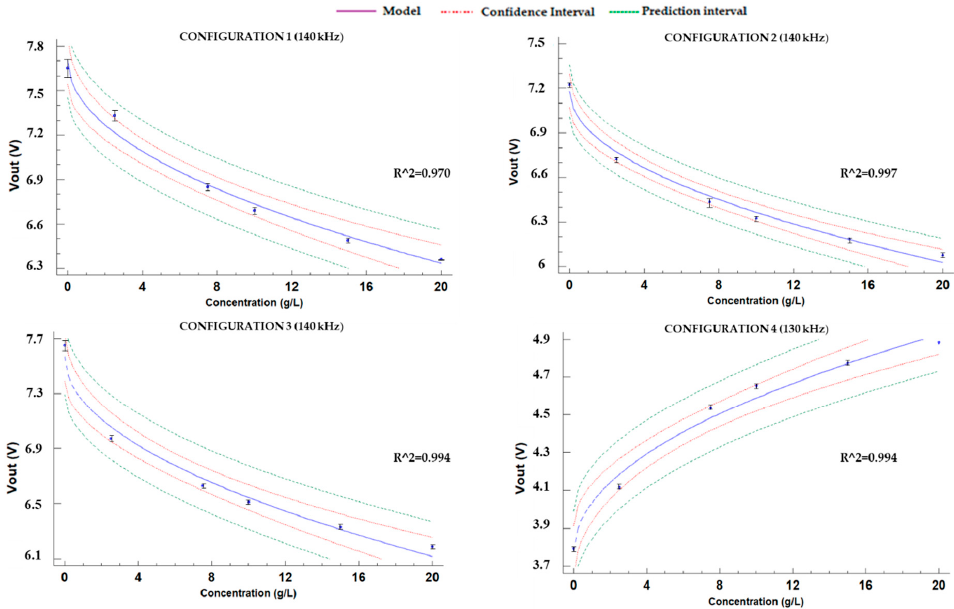
Figure 12. Adjusted models for P3.